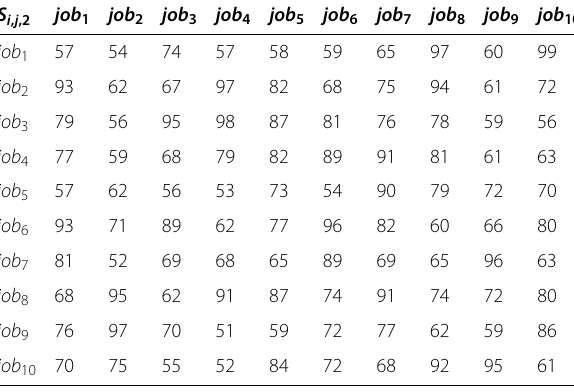
Table 4 Example of sequence-dependent setup times on machine 2